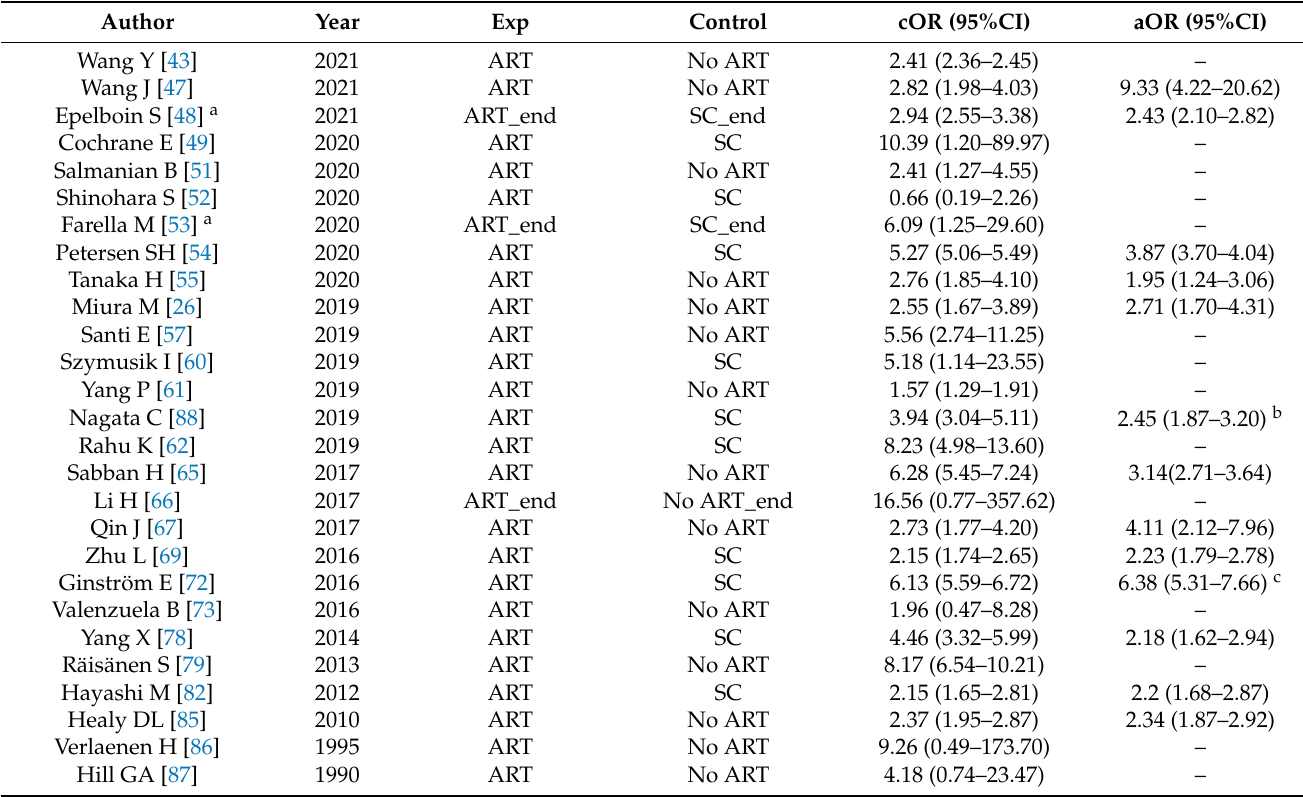
Table 3. Rates of placenta previa (ART versus no